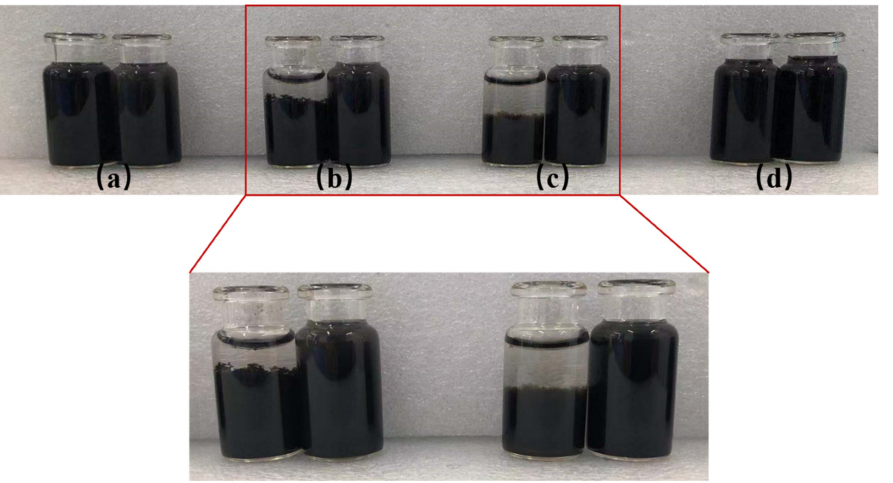
Figure 10. Dispersion effects of different systems: ( a ) [GO-W/PSG-W]; ( b ) [GO-CHS/PSG-CHS]; and ( c ) [GO-CAS/PSG-CAS]: ( d ) [GO-NHS/PSG-NHS].